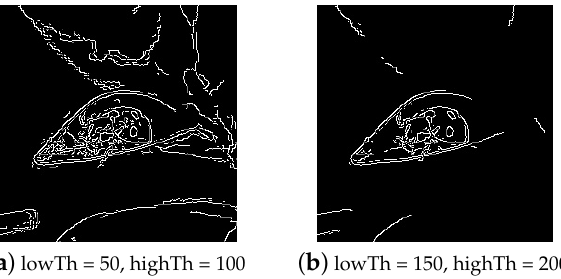
Figure 2. Edge detection by the Canny method for the low and high thresholds that are equal to: ( a ) 50 and 100 ( b ) 150 and 200,